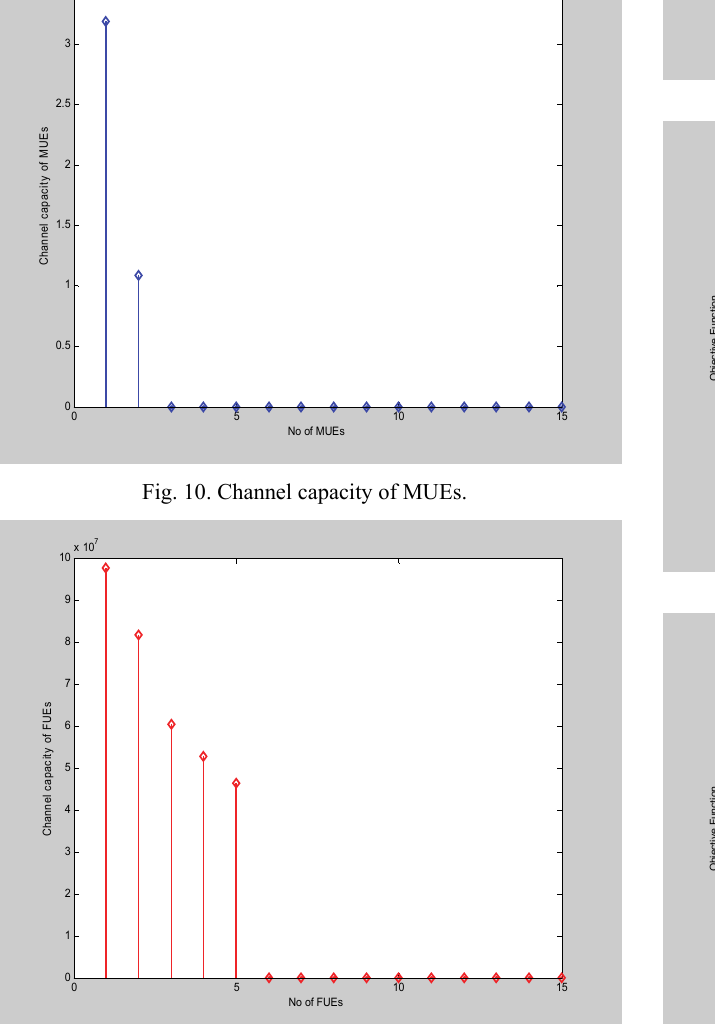
Fig. 11. Channel capacity of FUEs.